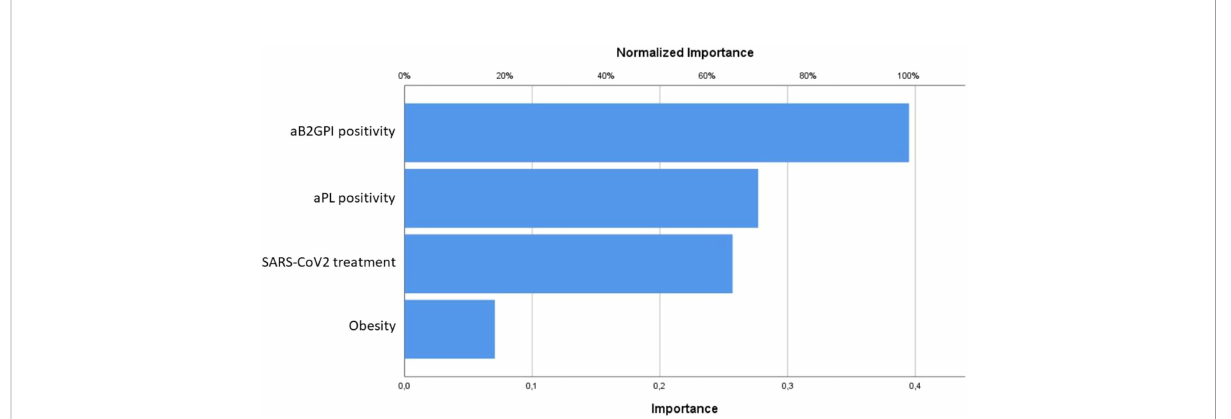
FIGURE 1 Predictive models resulting from the Multilayer Perceptron procedure for preeclampsia and HELLP syndrome, mainly in fl uenced by aB2GPI and aPL